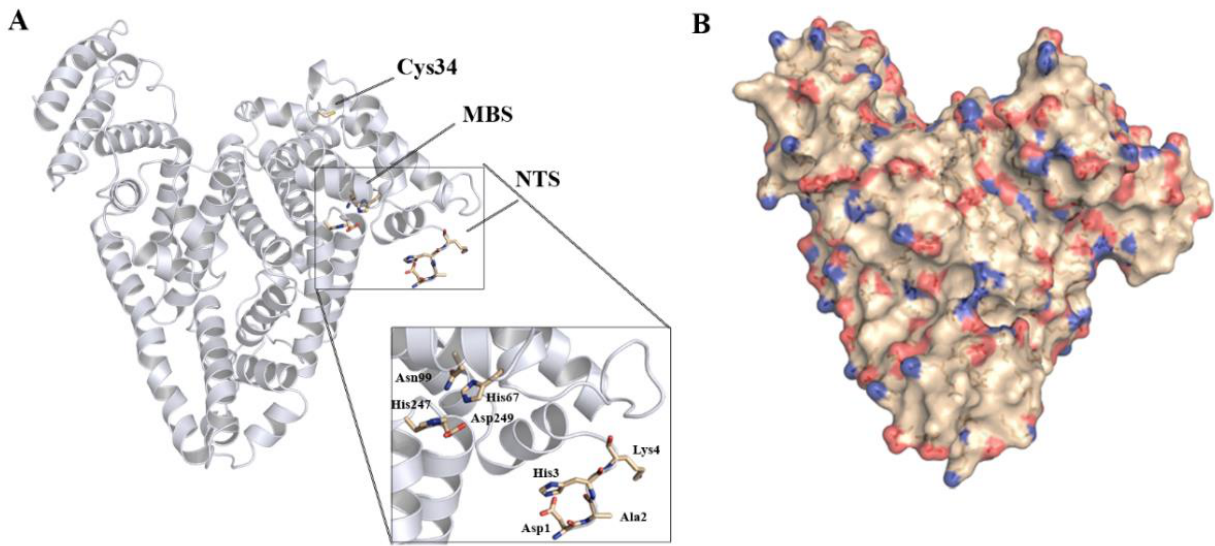
Figure 2. Human serum albumin structure (PDB: 1BM0 [94]). ( A ) Known metal ion binding sites in HSA: NTS (N-terminal site), MBS (Metal Binding Site A) and Cys34 (reduced cysteine at position 34). ( B ) Surface map from HSA, highlighting sidechain oxygen atoms from aspartate and glutamate residues (red) and sidechain nitrogen atoms from arginine and lysine residues (blue). The 4 N-terminal amino acid residues in the protein sequence were absent from the crystallographic structure and were manually modelled for this representation.